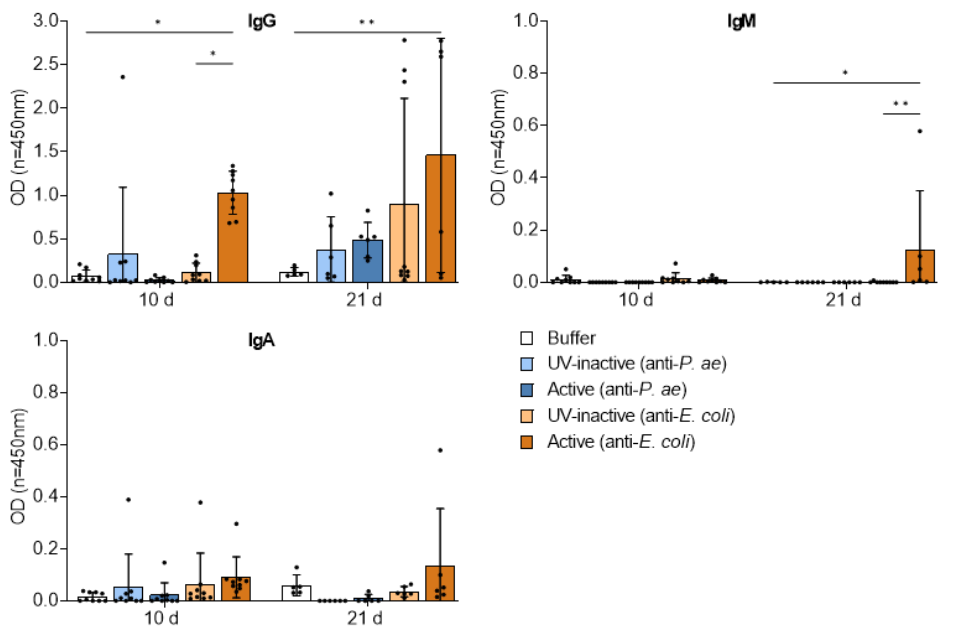
Figure 8. Repetitive phage treatment leads to anti-phage antibodies in plasma. Binding of plasma IgG, IgM and IgA to the active phage cocktails on 10 d and 21 d, as measured by ELISA. Results are shown as mean ± SD, as determined by 2-way ANOVA with Tukey ’ s multiple comparisons test: * p < 0.05. ** p < 0.01; n = 5 – 9 mice per group.